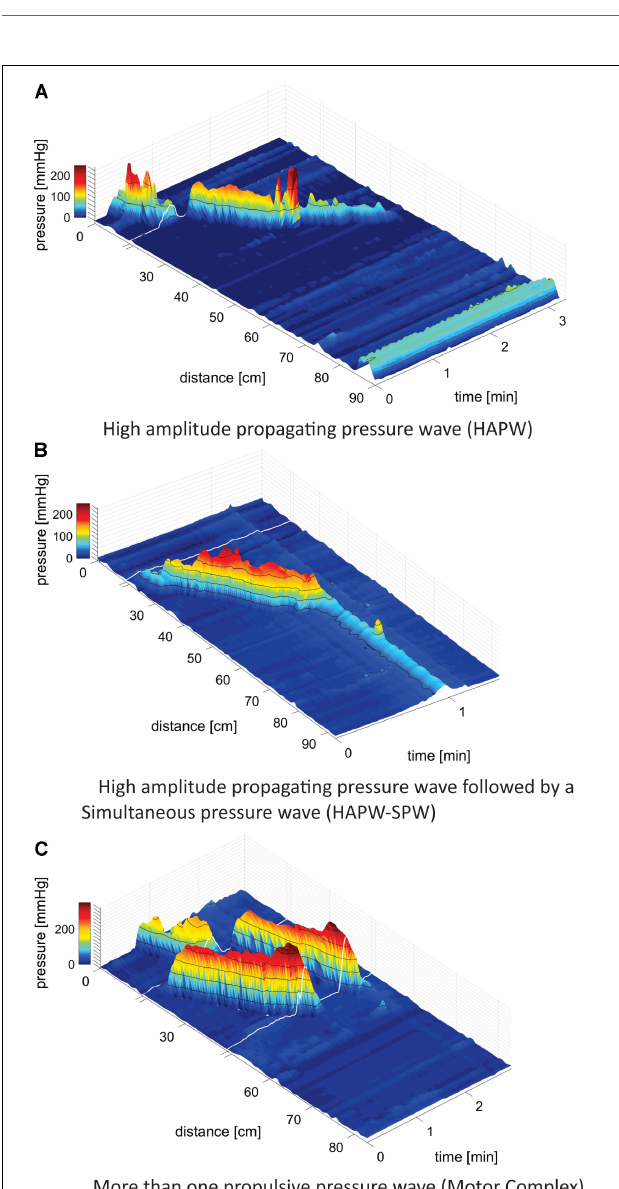
FIGURE 1 | Motor patterns. (A) High-Amplitude Propagating Pressure Waves (HAPWs) occurring as a single isolated event. White line indicates the presence of a 10 cm long balloon in the catheter where no data could be collected. The anal sphincter pressure is seen at 86 cm. 0 cm is in the proximal colon. (B) A HAPW followed by a simultaneous pressure wave (SPW) referred to as HAPW-SPW. White line indicates the presence of a 10 cm long balloon in the catheter where no data could be collected. The catheter was fully inside the colon such that the anal sphincter activity was not recorded. The HAPW started distal to the balloon. (C) Motor Complexes, defined as two or more distinct propulsive motor patterns that followed each other closely so that HRV changes could not be assessed for the individual patterns. In this catheter, two balloons were present at the white lines so that two sections of 10 cm did not have pressure sensors. No anal activity was